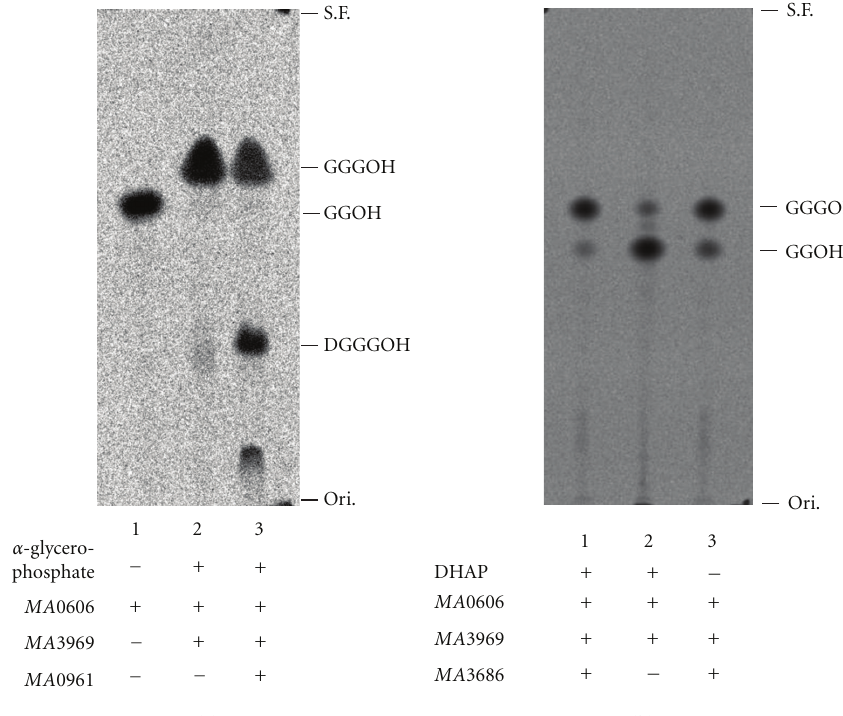
Figure 2: In vitro assay of the archaeal enzymes for phospholipid biosynthesis. (a) Thin-layer radiochromatogram of the dephosphorylated products from the reactions with recombinant M. acetivorans GGPP synthase, GGGP synthase, and/or DGGGP synthase. The enzyme assays were performed using FPP, [ 14 C]IPP, and α -glycerophosphate as the substrates. (b) Thin-layer radiochromatogram of the products from the reaction with recombinant M. acetivorans G-1-P dehydrogenase, coupled with GGPP synthase and GGGP synthase. FPP, [ 14 C]IPP, and DHAP were used as the substrates. S.F., solvent front; Ori.,